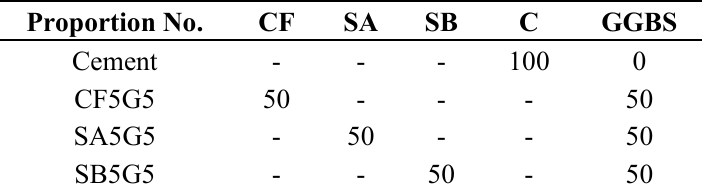
Table 1. Mixture proportions of blended materials (%).